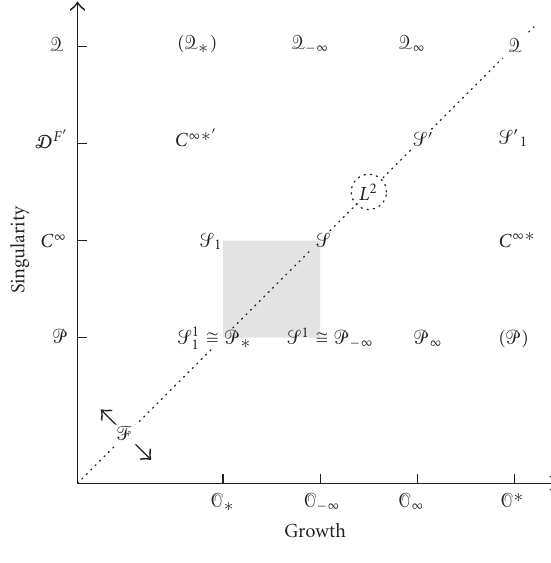
Figure 3.1. A diagram of generalized